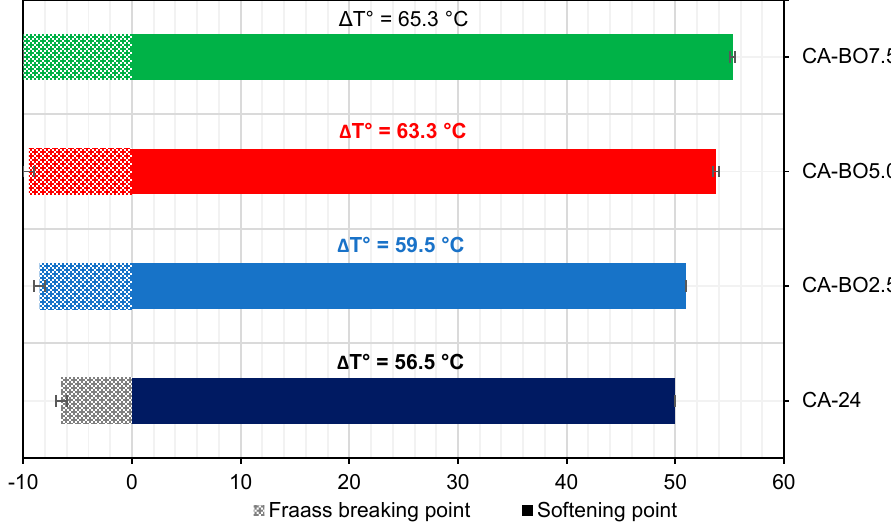
Figure 10. Viscoelastic range of the samples.